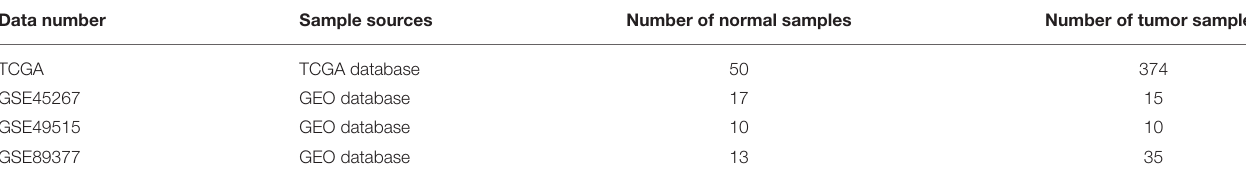
TABLE 1 | Collection of expression data of HCC.